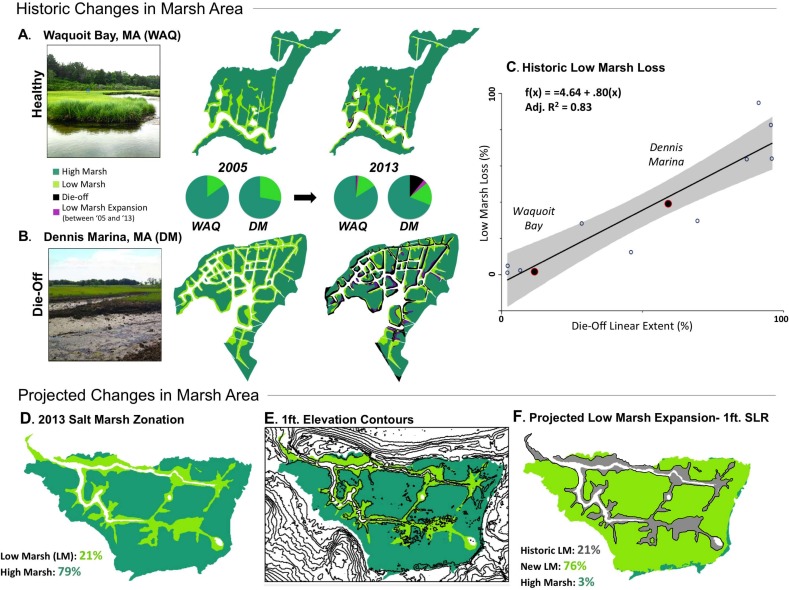
Historic and projected changes in New England marsh area.Representative healthy (A) and die-off (B) sites show different marsh loss trajectories between 2005 and 2013 and (C) linear regression analysis reveals that consumer driven die off linear extent explains 83% of the differences in historic low marsh loss across sites (N = 12). Representative projected areas of increased inundation, or new low marsh area, based on current low marsh border and LiDAR elevation data (D-F).